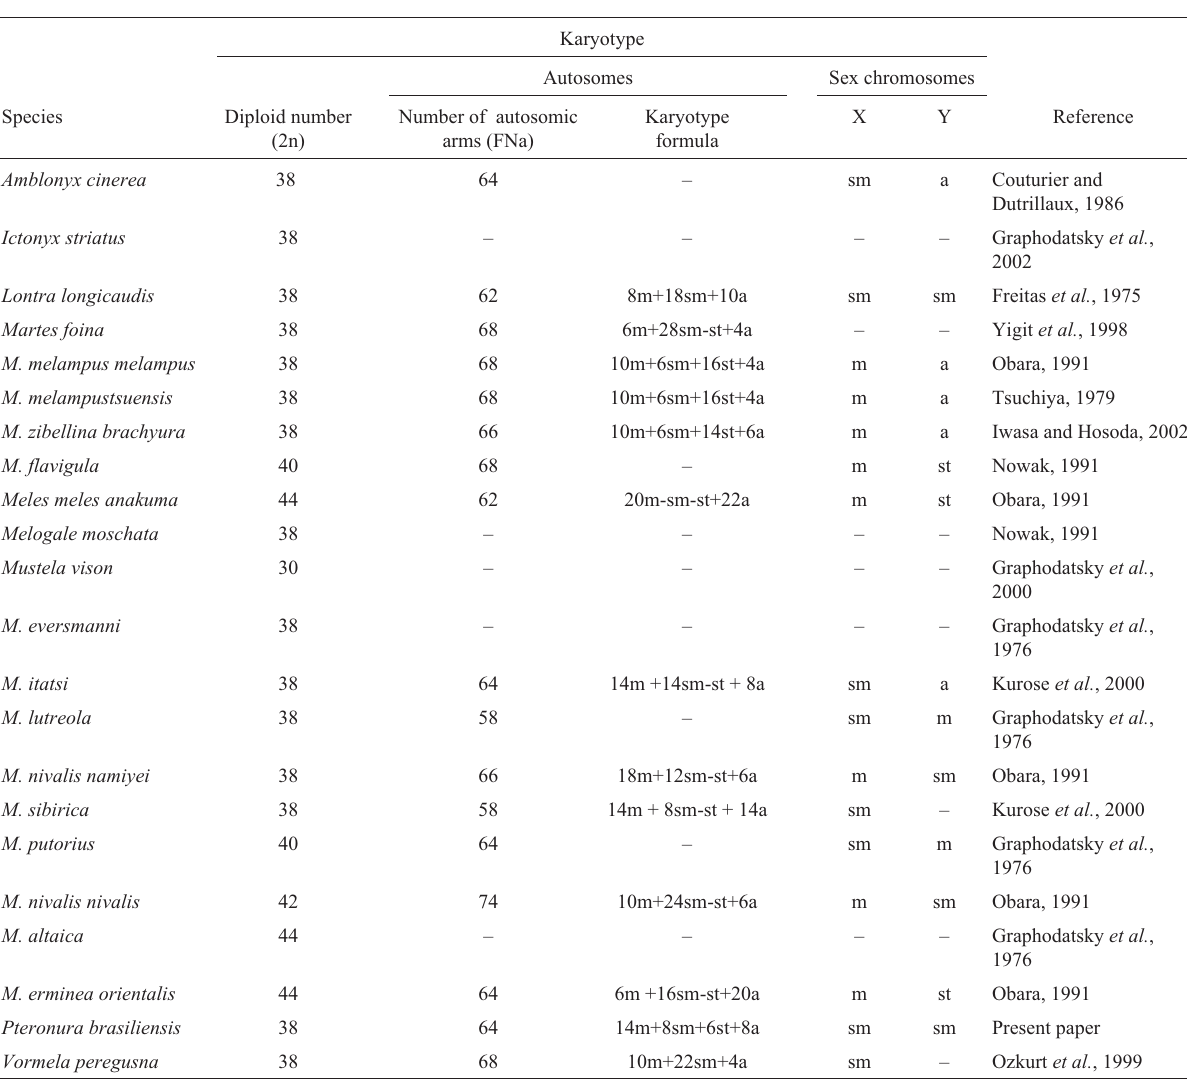
Table 1 - List of the chromosome number of 22 mustelid